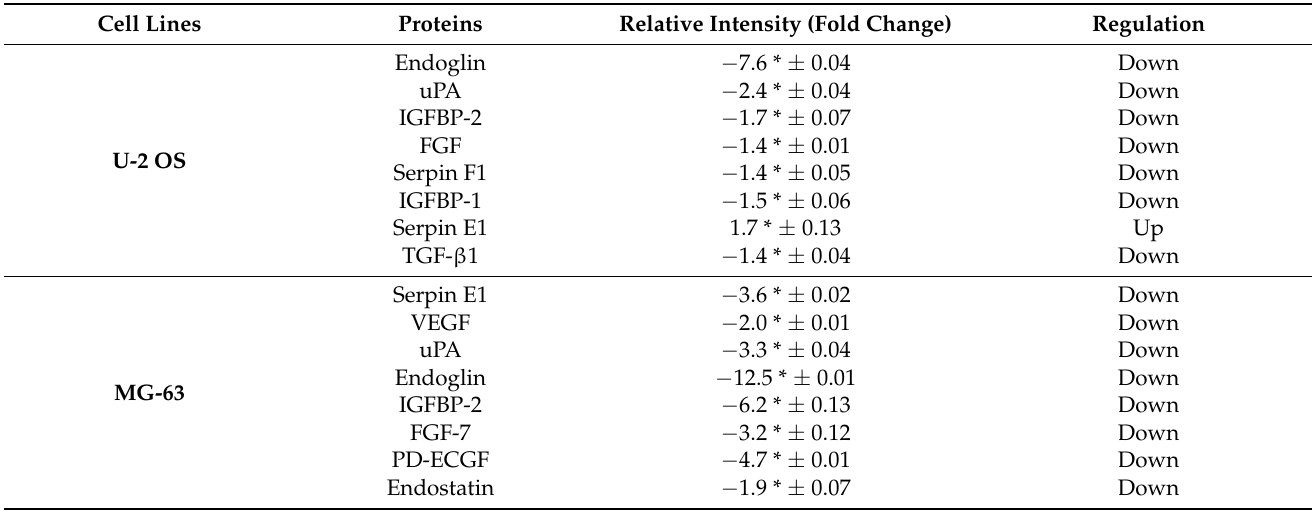
Table 3. Metastasis and angiogenesis related proteins expression in DK1 treated group for both U-2 OS and MG-63 osteosarcoma cell